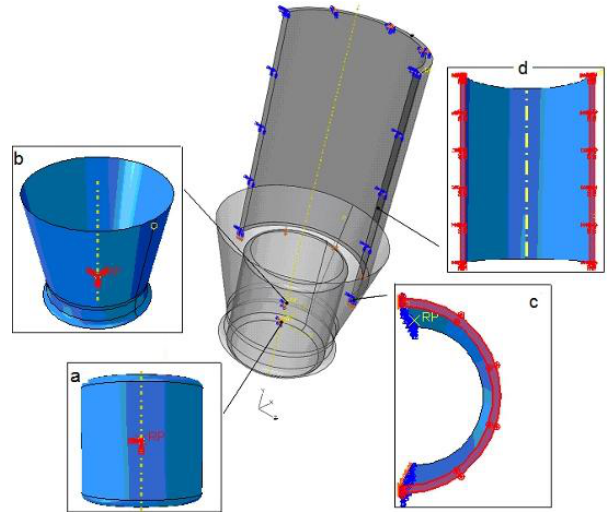
Figure 5. Boundary conditions: ( a ) reference point (RP) of the rigid plug; ( b ) RP of the rigid die; ( c ) tube surface; and ( d ) symmetric surface of the